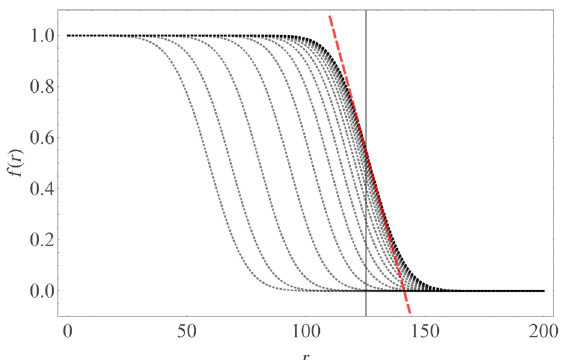
FIG. 20. Sequence of radial cross sections of the frequency of a linguistic variable whose initial domain is concentric with a city. Snapshots taken at times t ¼ 10 ; 30 ; 50 ; … starting from initial radius r ¼ 55 . Model parameters σ ¼ 5 , β ¼ 1 . 1 . In this example, 50 and peak density ρ 3 . Vertical line the city has radius R 1 ¼ c ¼ gives theoretical stable radius R 2 ¼ 125 . 3 computed from Eq. (41). Unstable radius [Eq. (40)] is R 1 ¼ 47 . 2 . Red dashed line gives the theoretical frequency gradient in transition region [Eq.